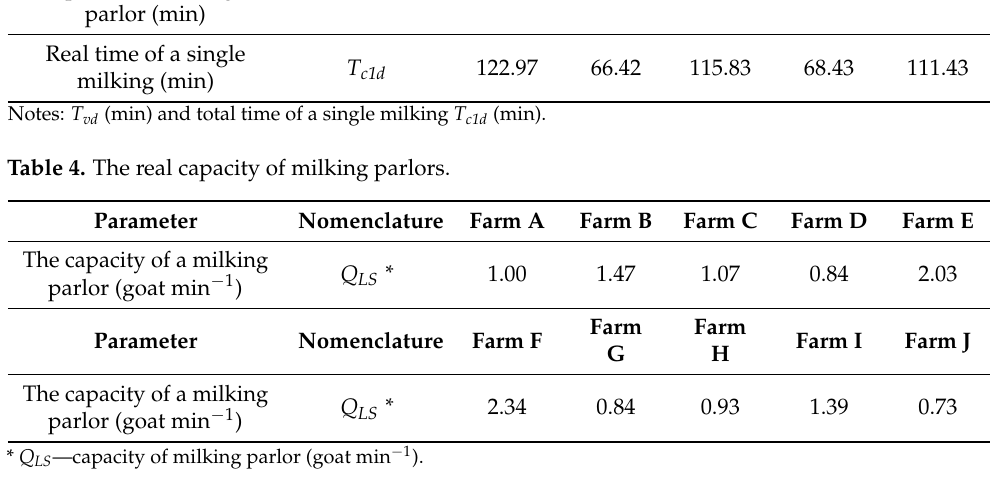
Table 5. The daily waste of time T L (min) and the specific financial losses related to labor u C L (EUR goat − 1 year − 1 ) in the goat